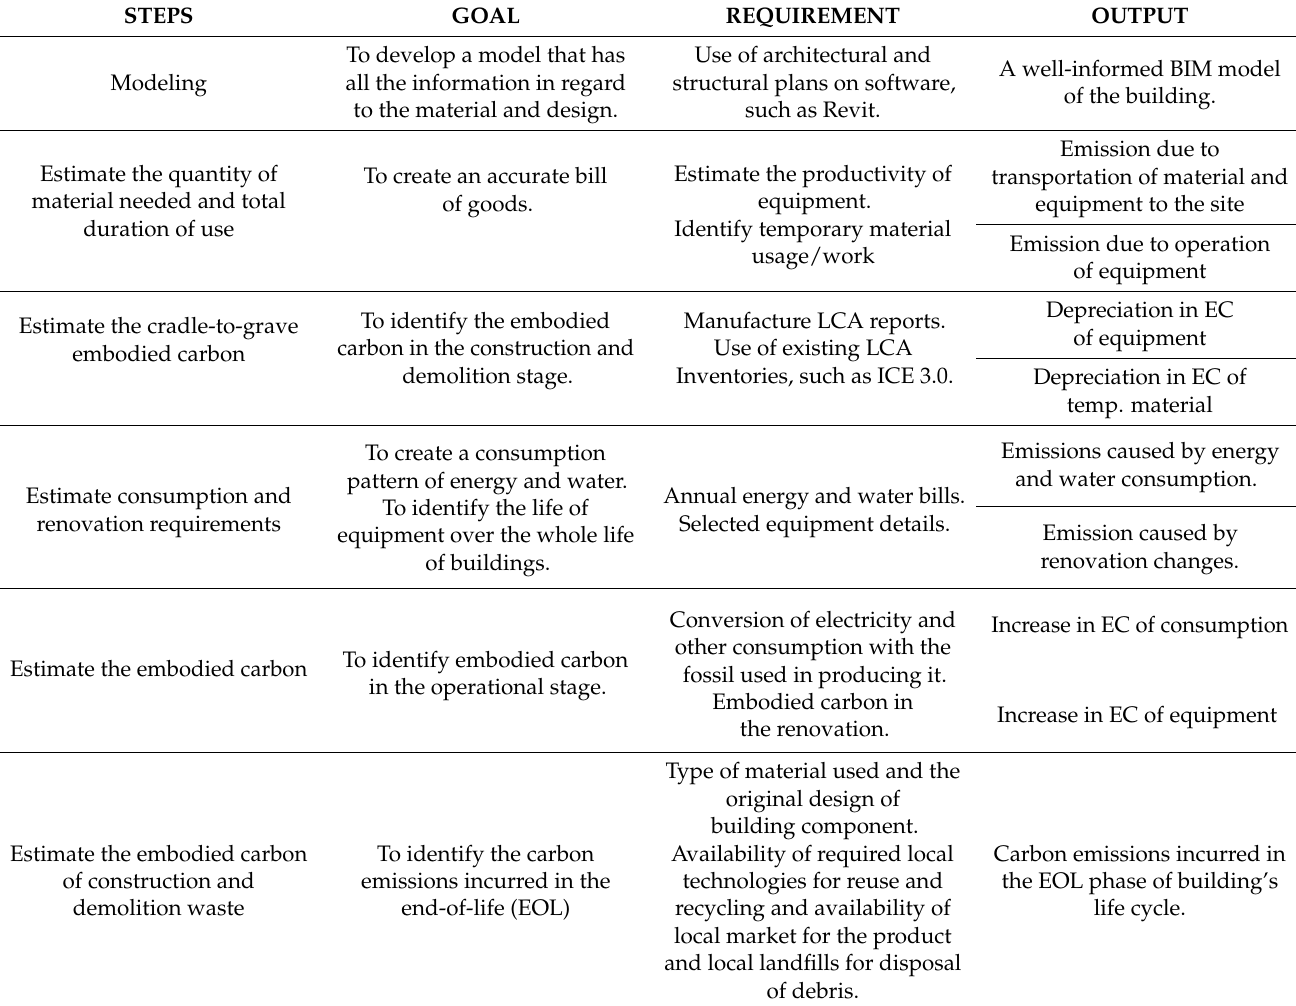
Table 1. Steps of estimation of embodied